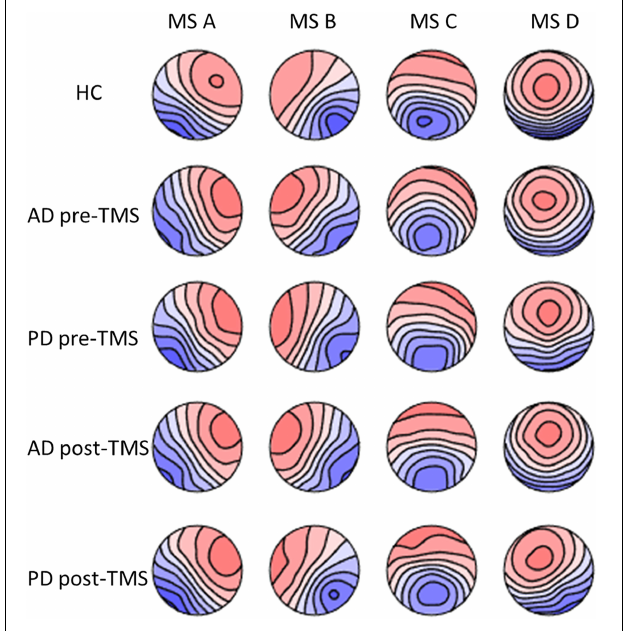
FIGURE 1 | The microstate maps of PD and AD groups at pre-rTMS and post-rTMS and HC group. p > 0.05. MS A, microstate A; MS B, microstate B; MS C, microstate C; MS D, microstate D; HC, healthy control; AD, Alzheimer’s disease patients; PD, Parkinson’s disease patients; pre-rTMS, before rTMS sessions; post-rTMS, after rTMS